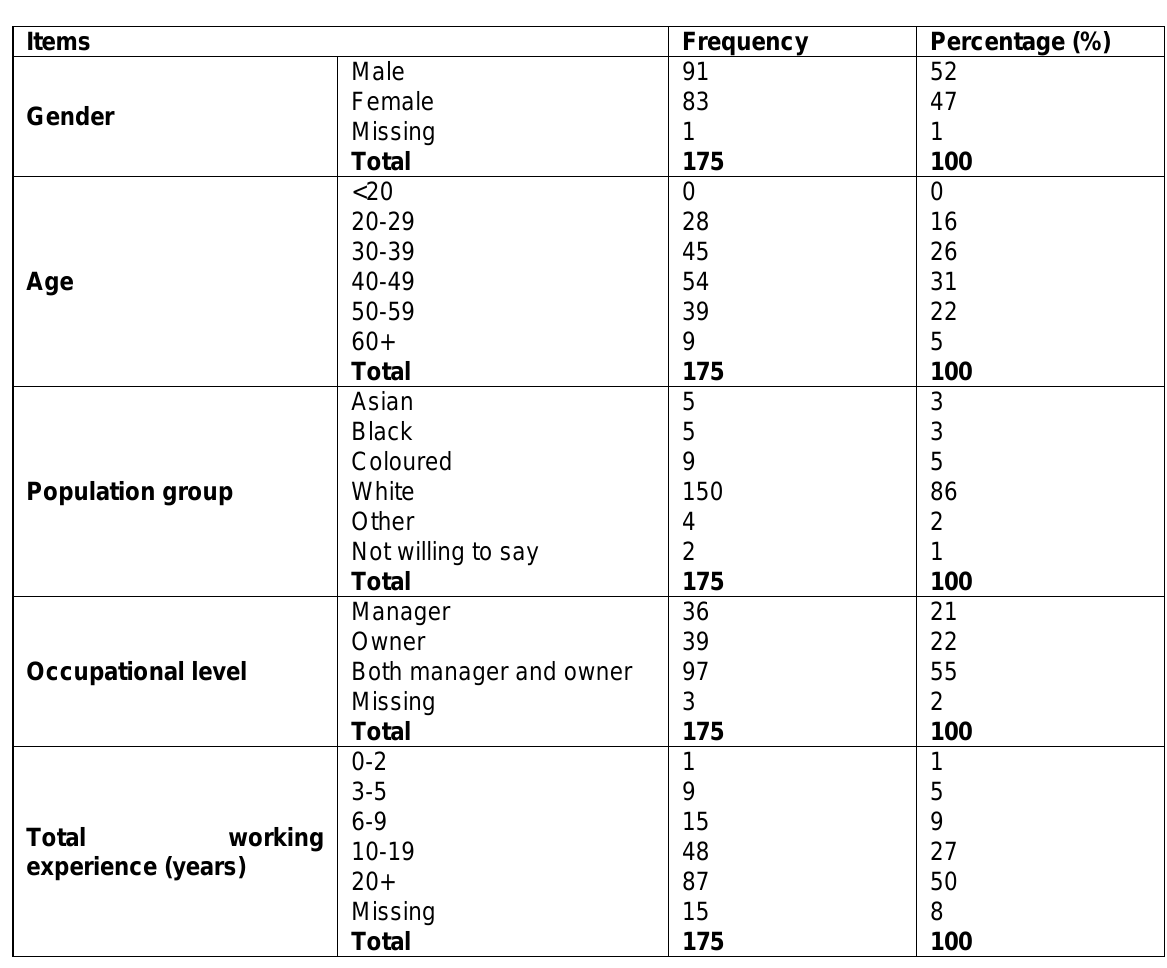
Table 1: Demographical data of